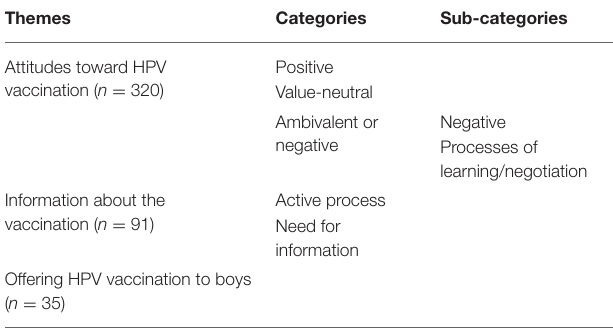
TABLE 6 | Open survey responses: themes and